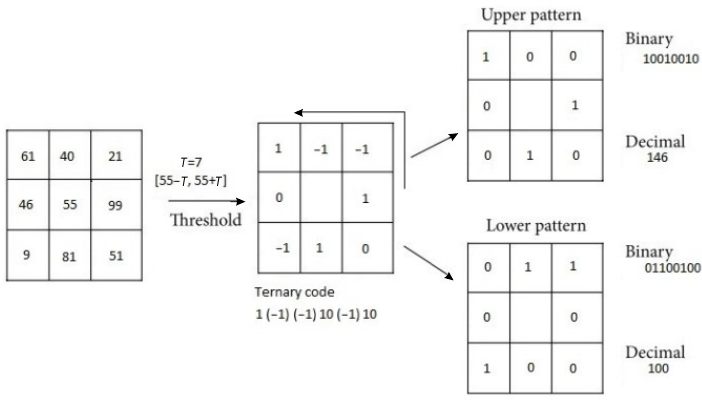
Fig. 4 LTeP code generation procedure of the center pixel.